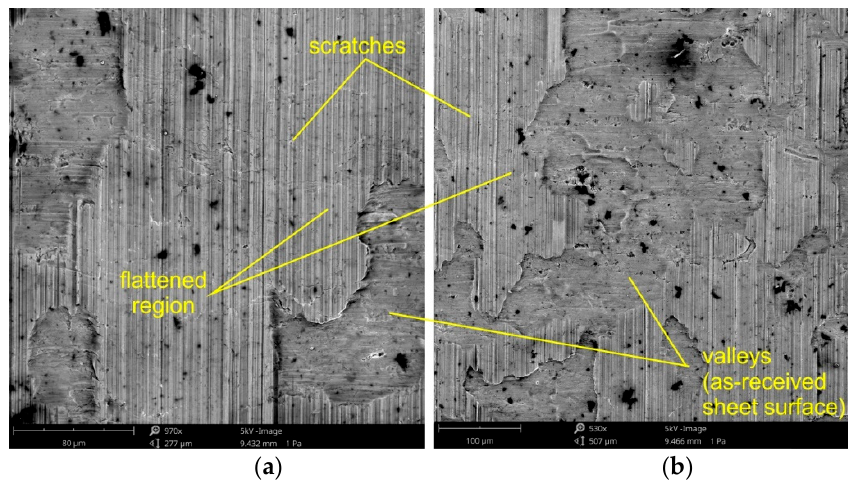
Figure 20. The specimen surfaces tested in lubricated conditions using LAN-46 machine oil (Ra = 0.63 µ m, h = 12 mm, w = 14 mm, orientation 90 ◦ ) at different magnifications: ( a ) × 970 and ( b ) × 530.